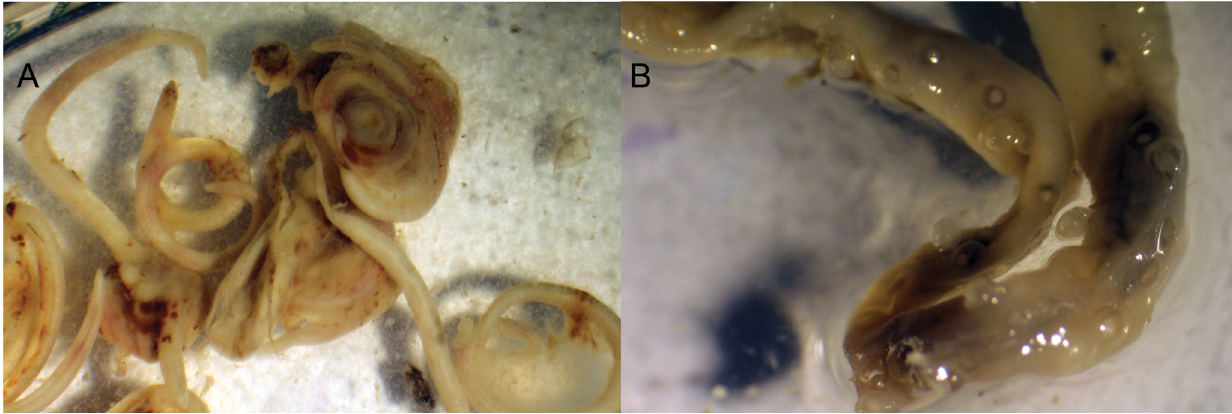
FIGURE 3 | Examples of parasites and lesions found in dissected Cathorops tuyra individuals. A. An example of parasites found in individuals from Rio Chagres, possibly belonging to the family Anisakidae. B. An example of the blister-like lesions on the outer wall of the intestines found in individuals from Rio Santa